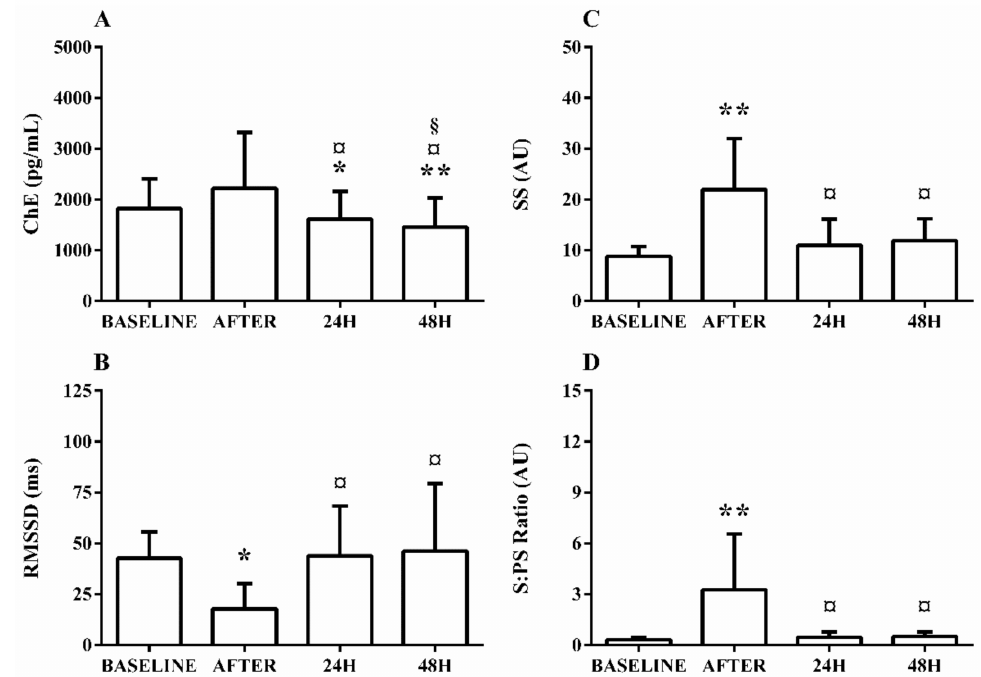
Figure 2. Changes in cholinesterases and HRV at baseline, postexercise, and 24H and 48H after recovery. ( A ) Cholinesterases, ( B ) root mean square of successive RR interval differences, ( C ) stress score, and ( D ) sympathetic/parasympathetic ratio. * p < 0.05, in relation to the BASELINE. ** p < 0.01, in relation to the BASELINE. ¤ p < 0.01, in relation to AFTER. § p < 0.05, in relation to 24H.